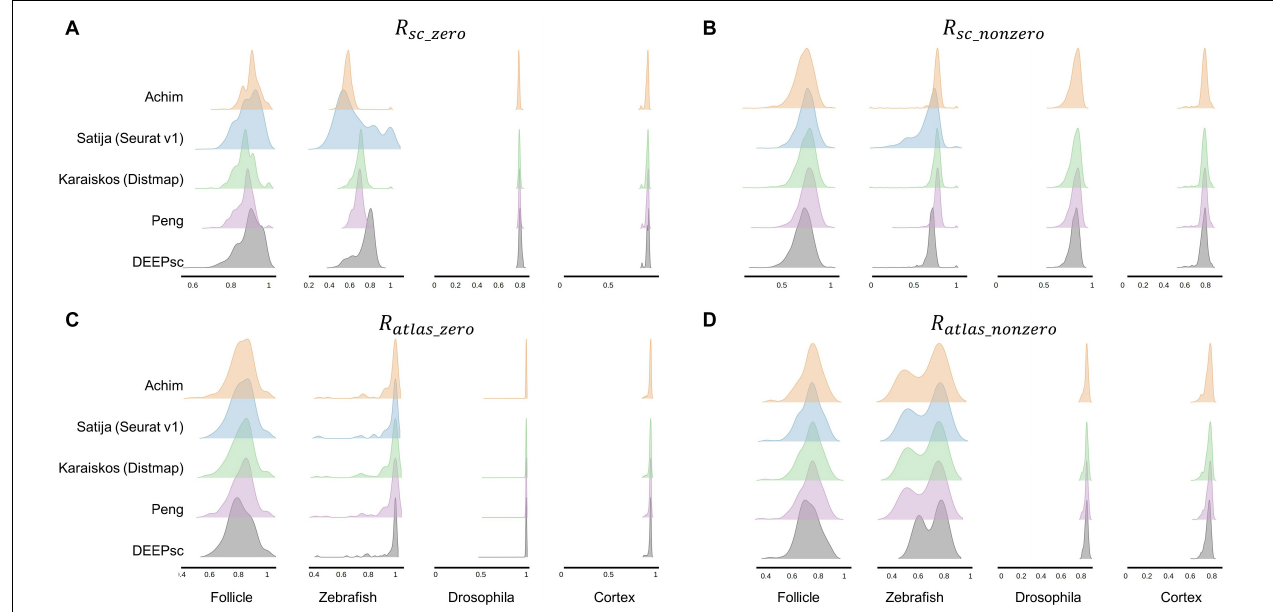
FIGURE 6 | Ridgeline plots of the zero (A) and nonzero (B) scRNA-seq predictive reproducibility of individual cells in the scRNA-seq datasets and zero (C) and nonzero (D) atlas predictive reproducibility of individual positions in the spatial atlas for the four studied systems. We were unable to run Seurat v1 on the Drosophila embryo and cortex data due to memory constraints.